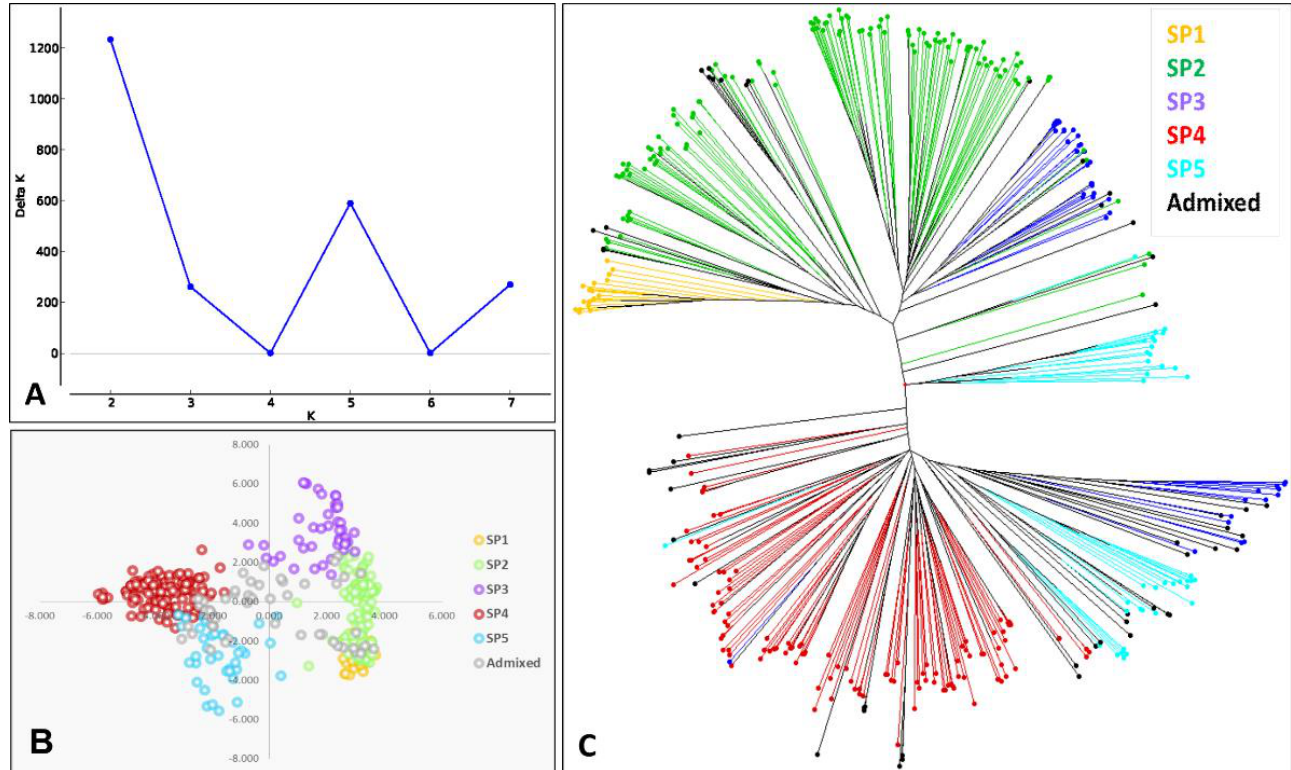
Figure 2. Genetic structure of the durum wheat collection. ( A ) Estimation of the number of subpopulations (SPs) according to the Evanno test. ( B ) Principal coordinates analysis (PCoA) based on genetic distance. ( C ) Unrooted neighbor-joining dendrogram. Table 1. Genetic diversity and gene flow between genetic subpopulations.